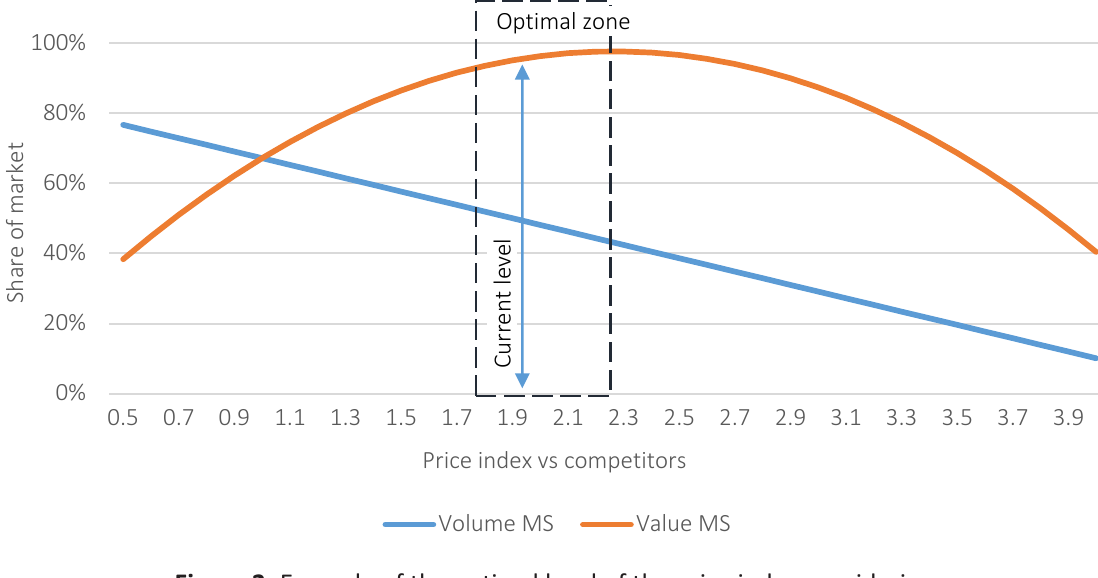
Figure 2. Example of the optimal level of the price index considering the growth of market share in money